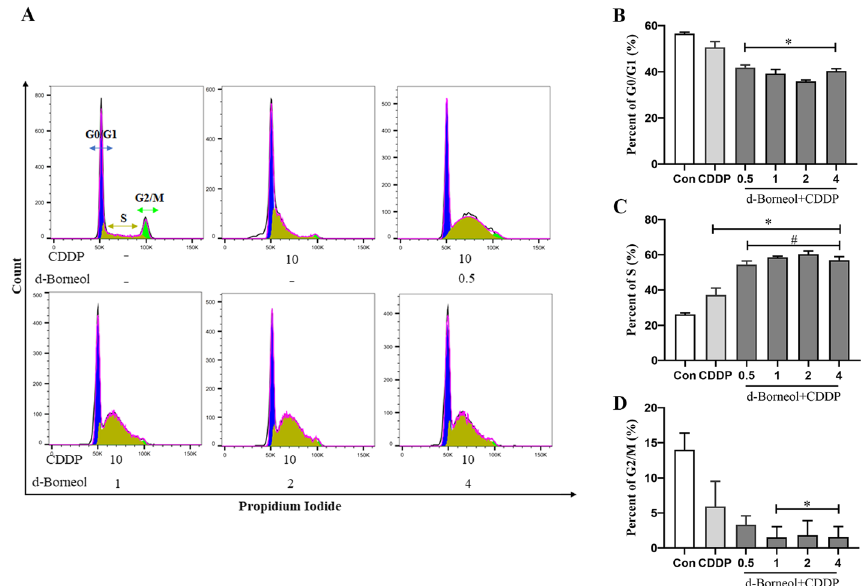
Fig. 3 d-Borneol arrested cell cycle at S phase. A Cell cycle distribution of H460/CDDP cells detected by flow cytometry; B – D histogram and relative statistical analysis of H460/CDDP cells in G0/G1 phase, S phase, and G2/M phase. All data are presented as mean with CDDP